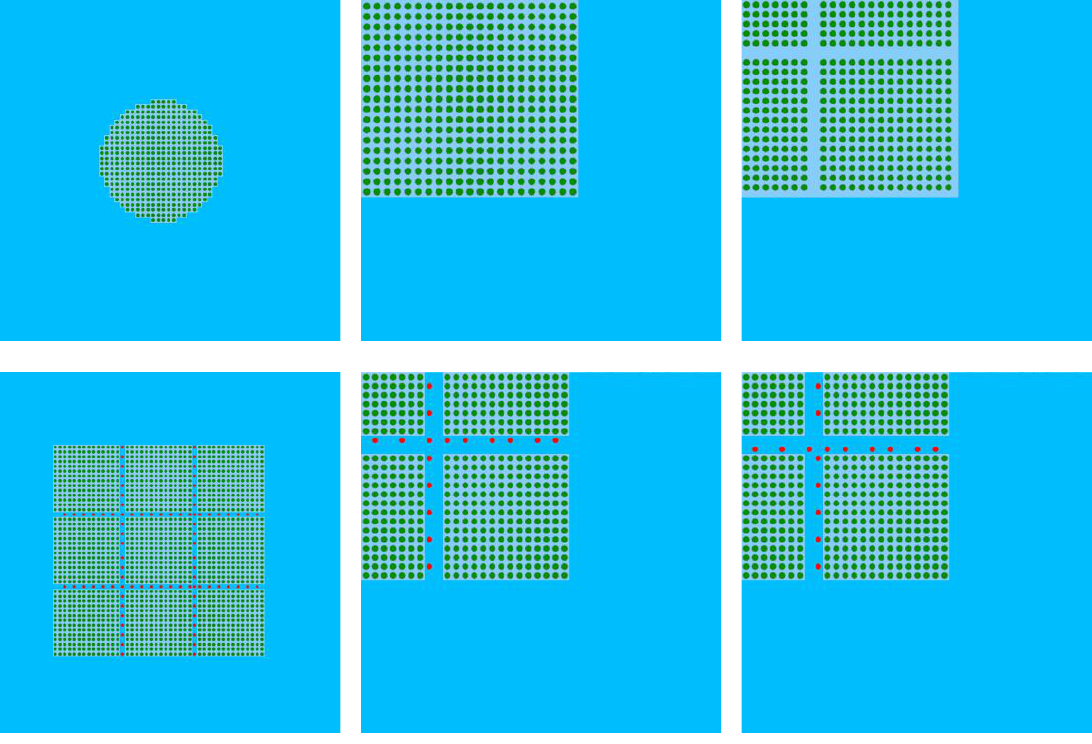
Figure 3. CASMO5 multi-assembly depiction of B&W 1484 Cores I through VI (left to right, top to bottom). Absorber rods containing B C are depicted as red 4